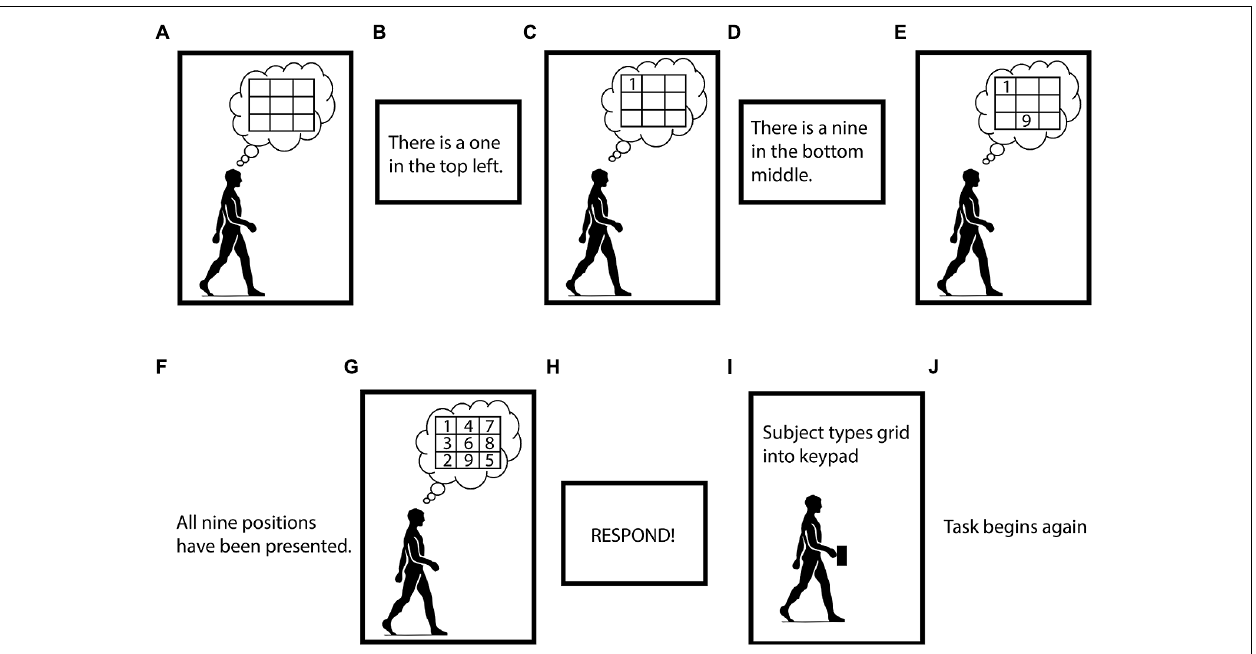
FIGURE 2 |Visual depiction of the Brooks spatial working memory task. Panels (A–J) indicate the order of the task. Subjects performed the Brooks task continuously for 5 min